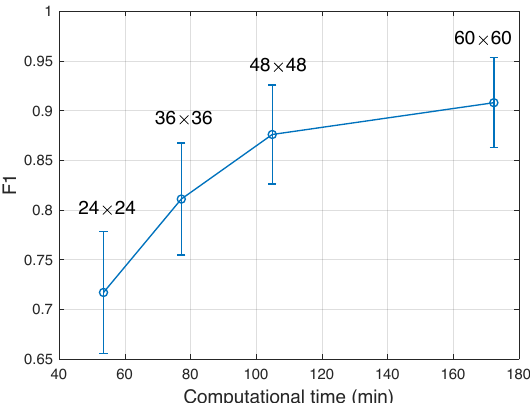
Figure 5. Detection accuracy ( F 1) on the verification set with model training time on the verification set using four different τ